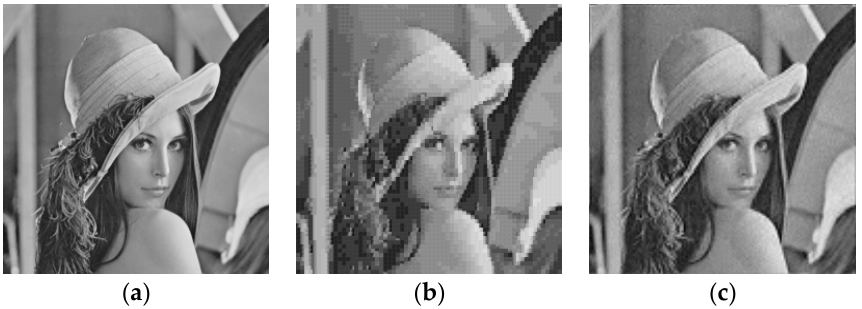
Figure 4. Images Lena: ( a ) Original; ( b ) Reconstructed using spatial domain VQ with 0.3125 bpp (PSNR = 25.62 dB and SSIM = 0.7211); ( c ) Reconstructed using DWT VQ with 0.3125 bpp (PSNR = 29.35 dB and SSIM = 0.8367). Codebooks were designed with training set P-M-T by MFKM2-ENNS.